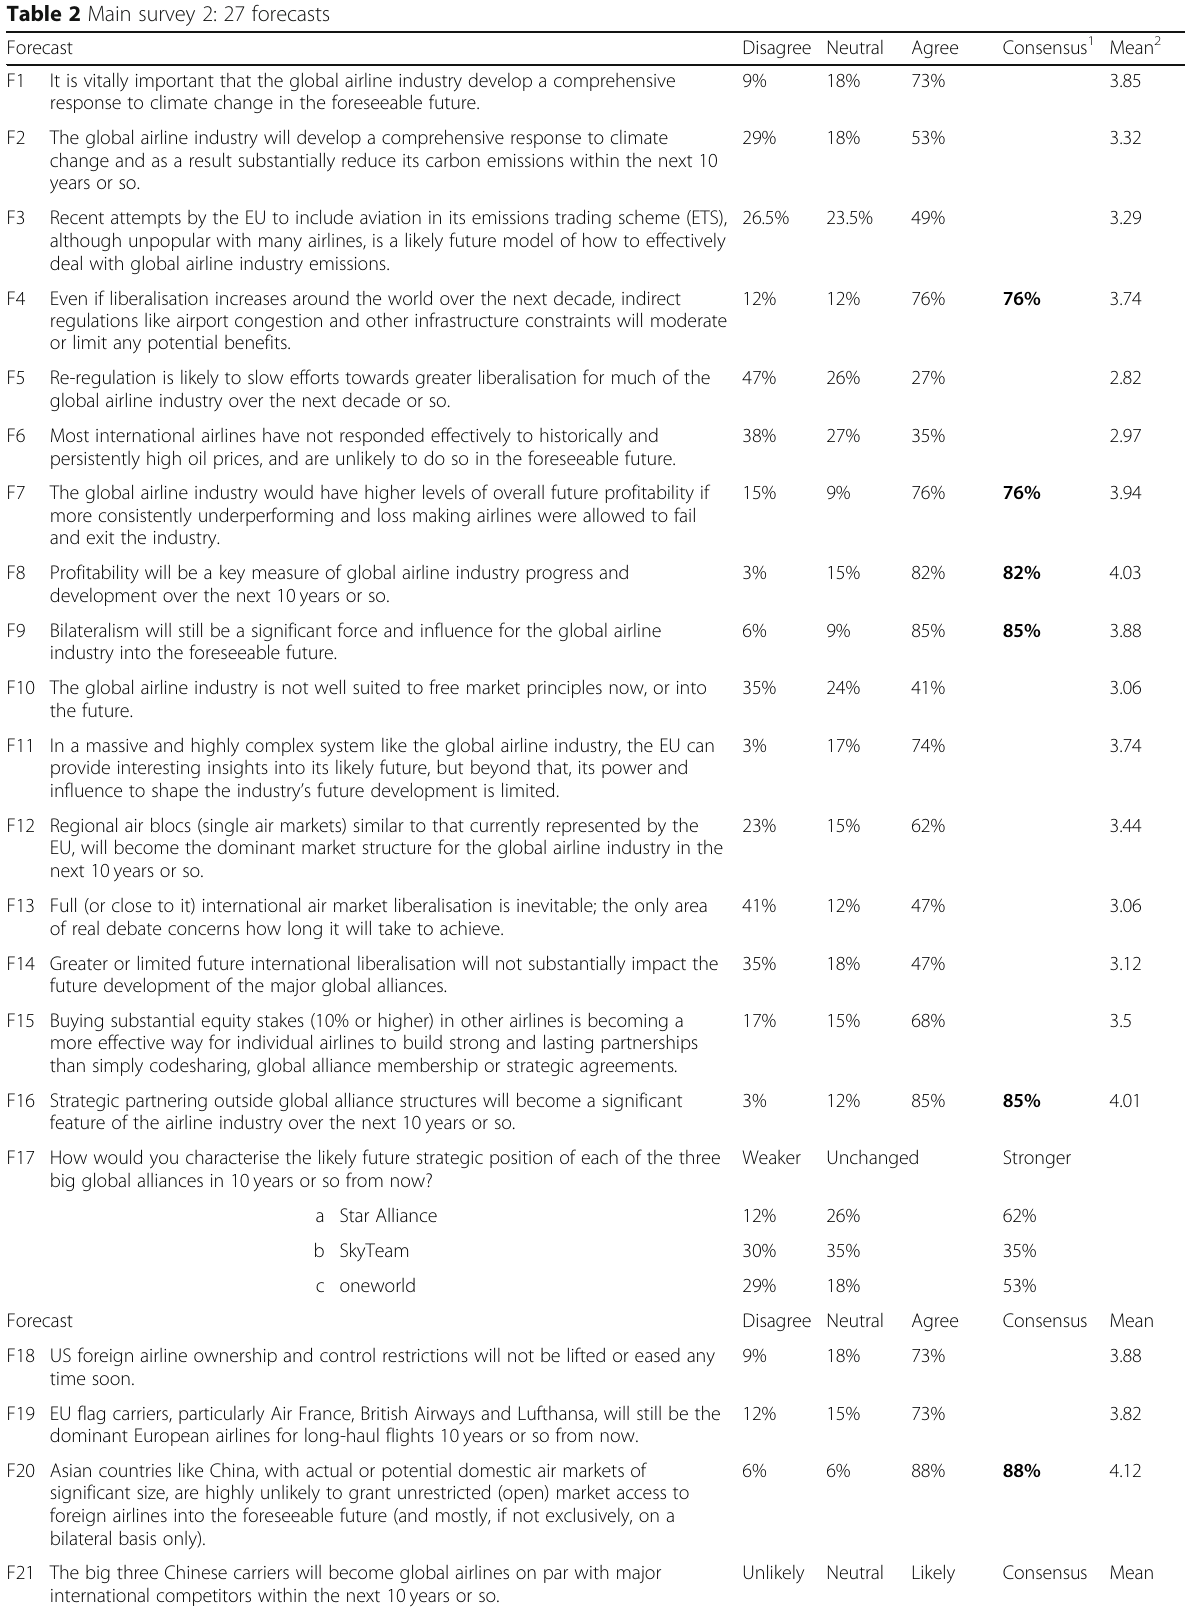
Table 2 Main survey 2: 27 forecasts Forecast Disagree